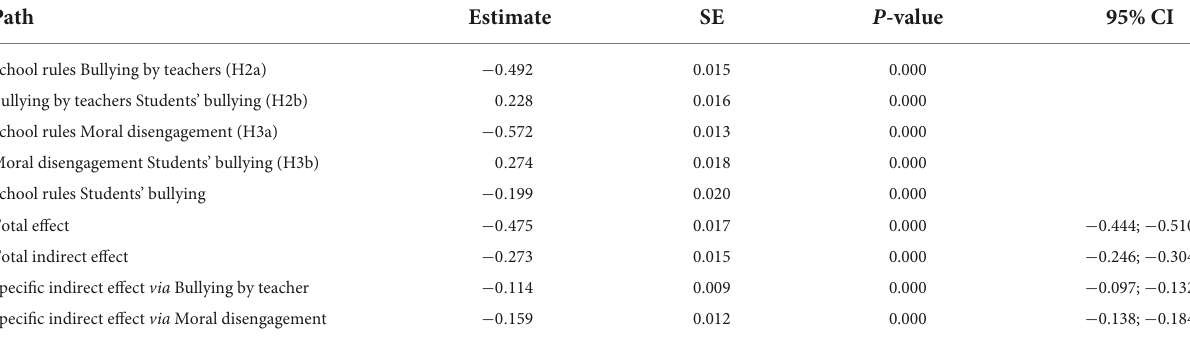
TABLE 2 Path coefficients (standardized) in the model of school disciplinary structure and peer bullying, mediated by bullying by teachers and moral disengagement.